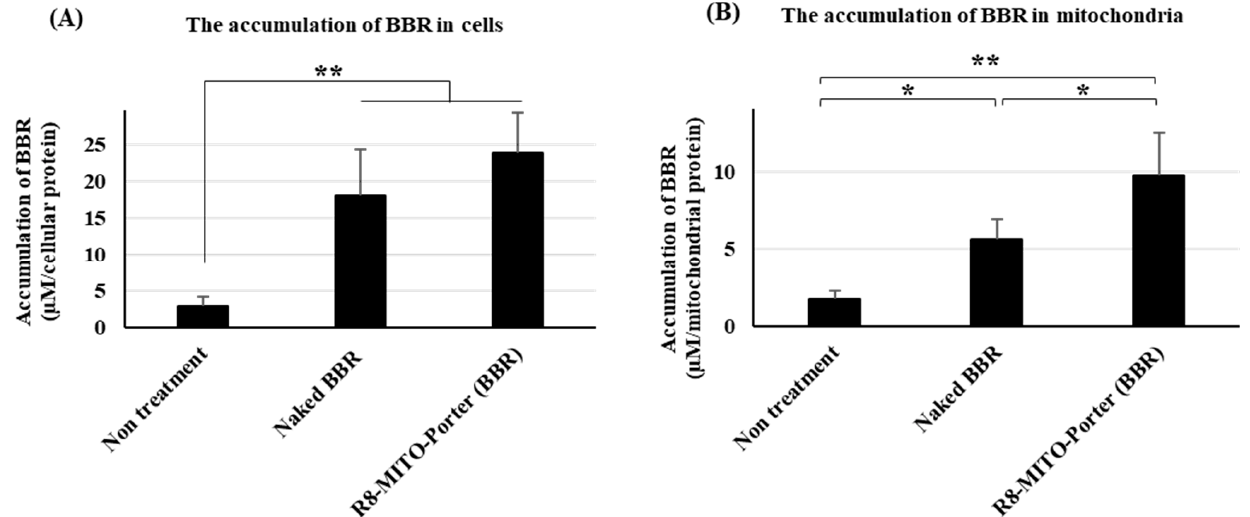
Figure 3. Evaluation of the accumulation of BBR into cells and mitochondria. After treatment with these samples, the medium was replaced, and the resulting preparation was incubated for 4 h. Measurement of the concentration of BBR in cells and mitochondria. ( A ) BBR concentration in cells. ( B ) BBR concentration in mitochondria. Data are represented as the mean ± S.D. (n = 3). * p < 0.05, ** p < 0.01, one-way ANOVA followed by Student–Newman–Keuls test.